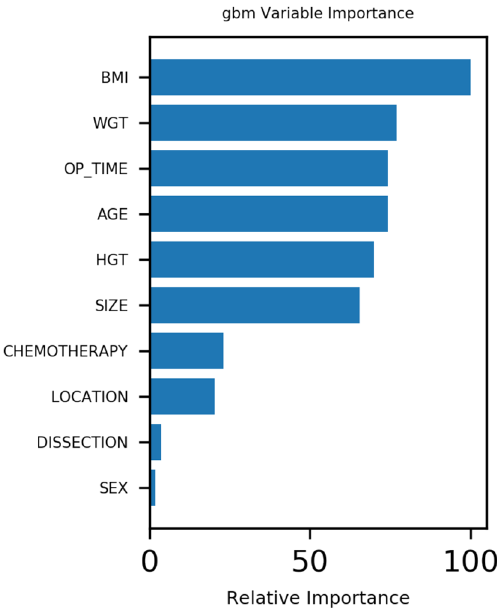
Figure 2. Variable importance of features included in the machine learning algorithm for prediction of recurrence of patients with gastric cancer after operation. Note : gbm: LightGBM.